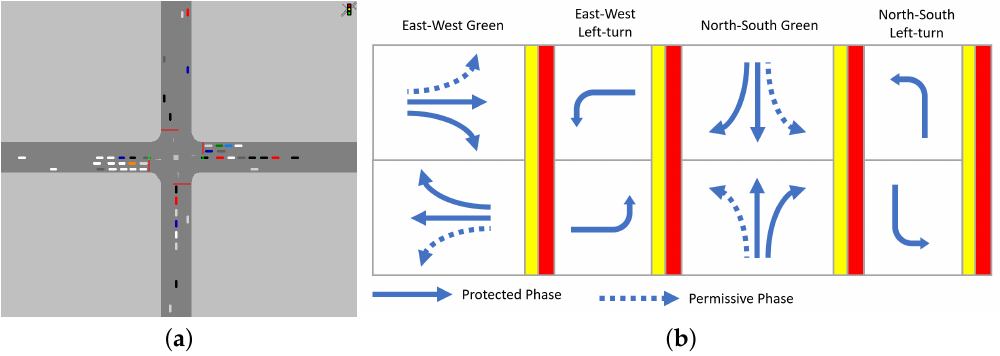
Figure 4. Intersection traffic simulation in Vissim. ( a ) Simulated intersection traffic; ( b ) Traffic signal